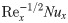
Time-series of the Nusselt number Rex−1/2Nux and temperature profile θ in the first five periods τ ∈ [0, 10π] at a fixed distance from the sheet y = 0.25: (a) effects of Pr with K = 0.1, γ = 0.1, β = 12 and S = 1 and (b) effects of γ with K = 0.1, β = 12, and S = 2, Pr = 0.5.